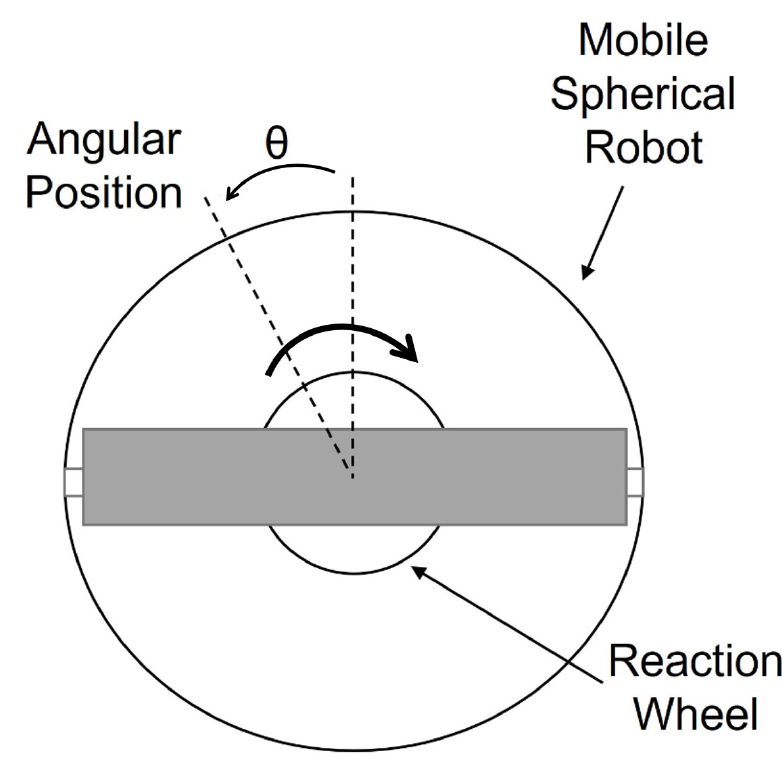
Figure 5. Top view of the robot for rotational